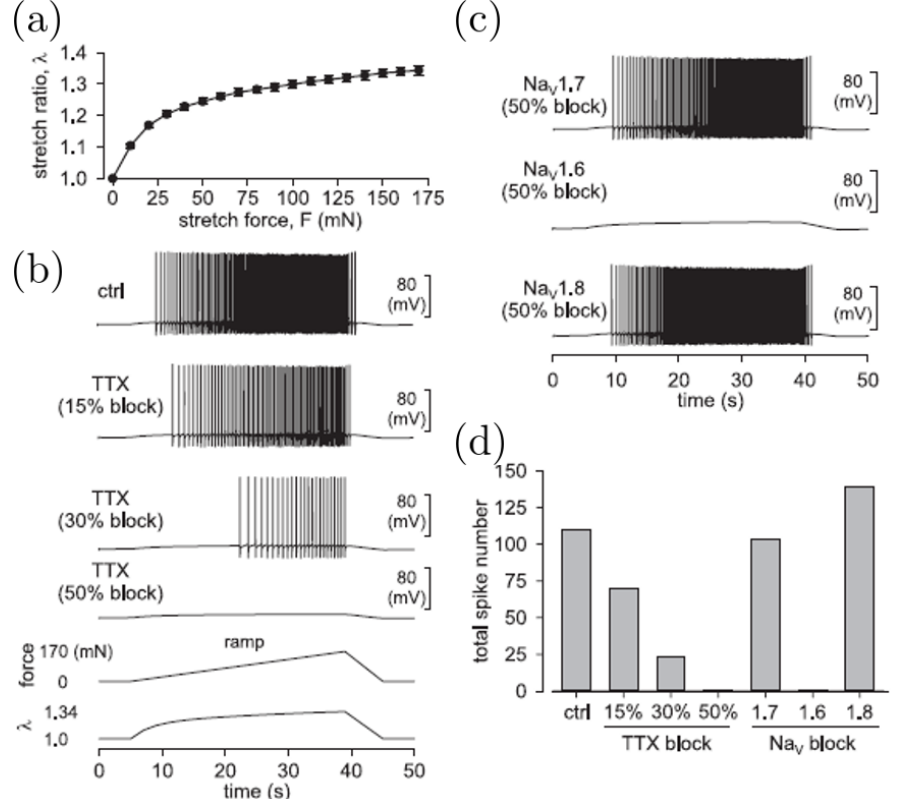
Figure 4. Simulations of localized serosal application of tetrodotoxin (TTX) and selective Na V 1.6 and Na V 1.7 blockers on stretch-sensitive colorectal afferent endings. ( a ) The ramped circumferential stretch λ determined experimentally. ( b , c ) We used the measured mean stretch to drive the afferent ending model for action potential generation: ( b ) TTX and ( c ) Na V 1.6, Na V 1.7, and Na V 1.8. ( d ) The predicted total spike numbers (adapted from